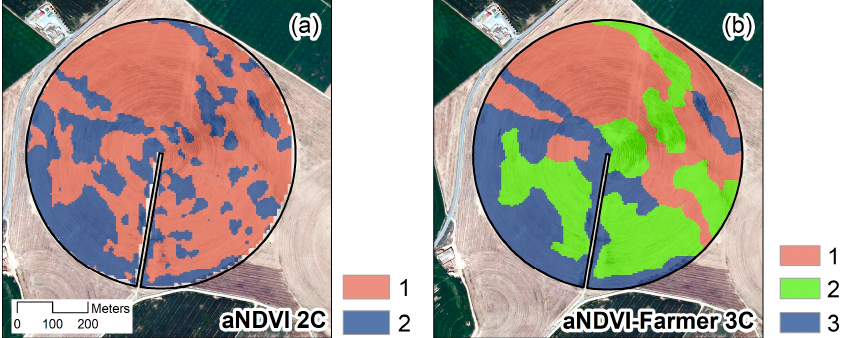
Figure 7. Comparison of the potential management zone (PMZ) maps according to ( a ) the clustering of the accumulated NDVI (aNDVI, two classes), and ( b ) the classes as result of adding the farmer’s expert knowledge (three classes).